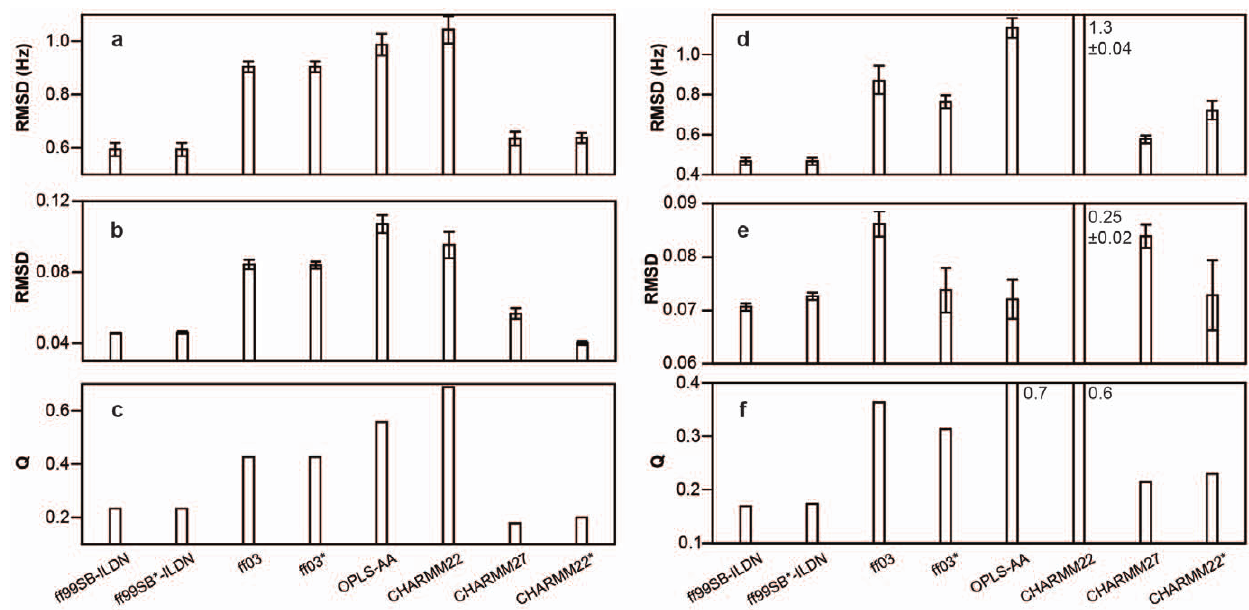
Figure 1. Comparison between simulation and experimental NMR data probing the structure and dynamics of the backbone in folded proteins. The plot shows the results for (a, b, c) ubiquitin and (d, e, f) GB3. In (a, d) we show the agreement between calculated and experimental scalar couplings, in (b, e) the agreement between calculated and experimental order parameters, and in (c, f) the agreement between calculated and experimental residual dipolar couplings. Low RMSD values or Q scores [39] imply better agreement with experiments. Error bars represent the standard error of the mean. curve. As for the AAQAA system, the eight force fields display a broad range of behaviors, with the very helical CHARMM27 force field being the biggest outlier, as it forms almost no folded structures at any temperature.